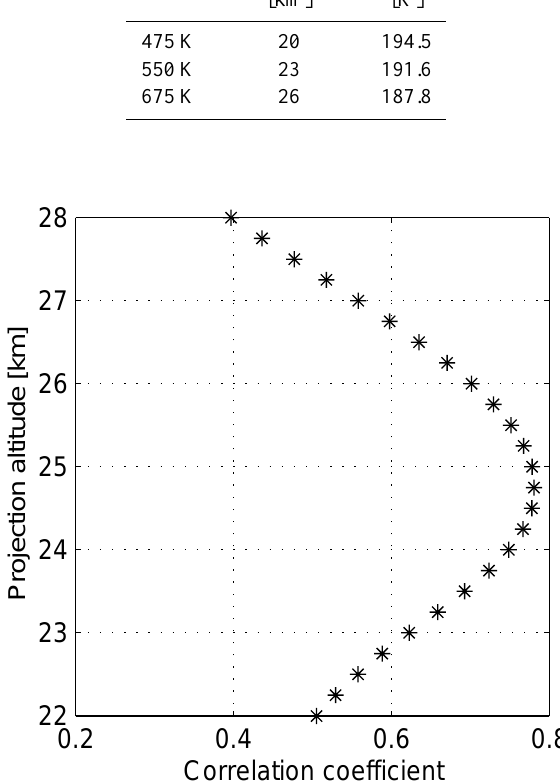
Fig. 8. Typical coefficients of 2-D spatial correlations of image pairs projected to consecutive